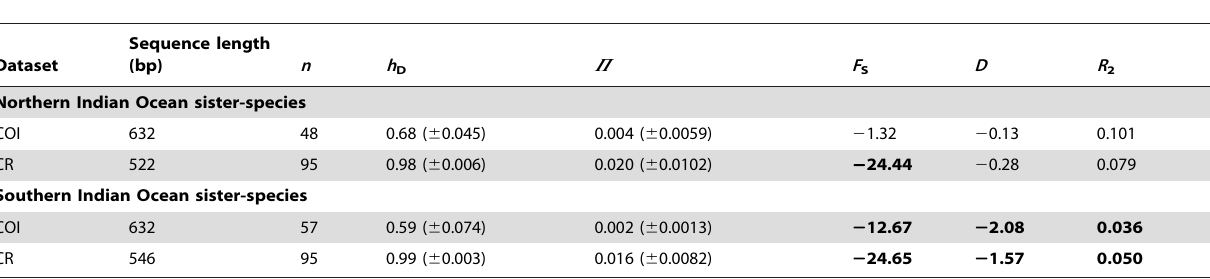
Table 1. Summary statistics per sister-species and dataset.